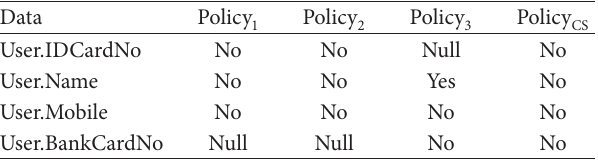
Table 8: Optional values of Data elements in